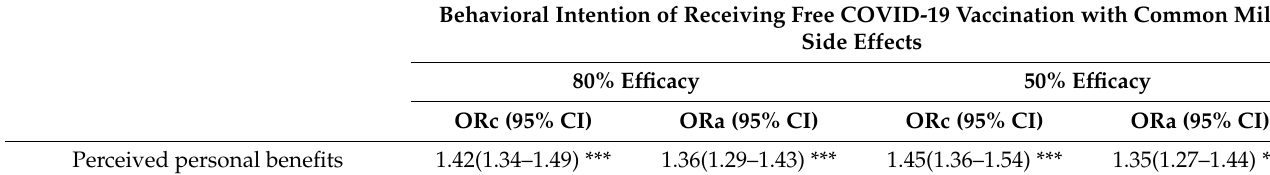
Table 3. Individual associations between the independent variables and the two outcomes of behavioral intention of COVID-19 vaccination.